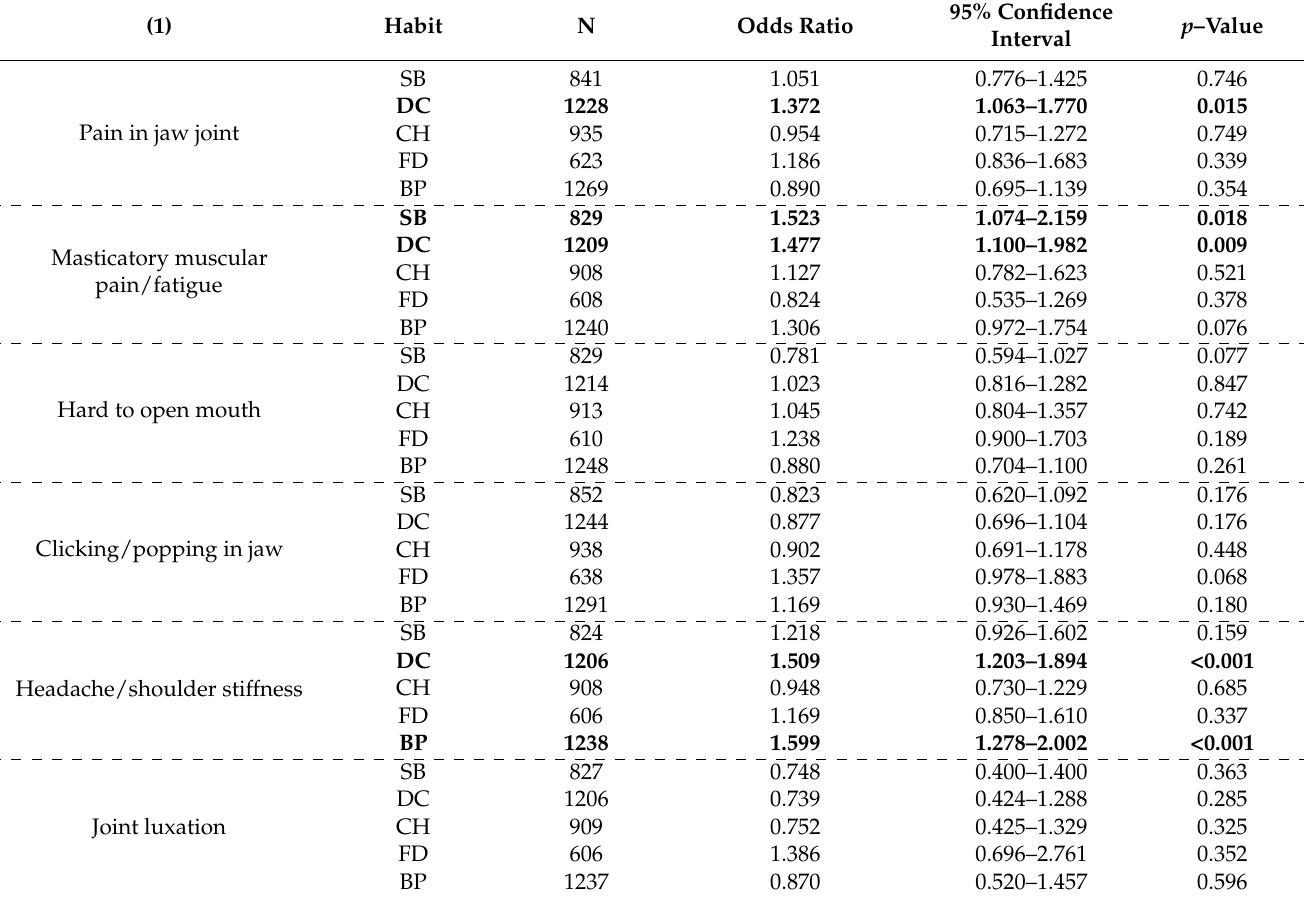
Table 4. Logistic regression analysis of TMD symptoms with the presence of targeted habit with reference to the absence of SB in the propensity-matched group. (1) Regardless of the presence or absence of other OPFHs and PHs. (2) In cases where other OPFHs and PHs are absent, except for the targeted